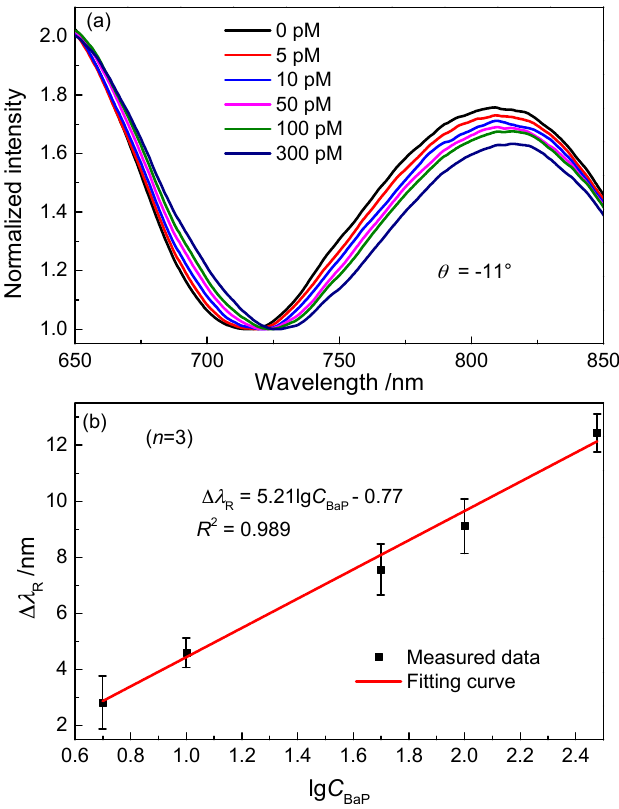
Figure 6. ( a ) SPR spectra measured at θ = − 11° with the antibody-functionalized NPG film in air after immunoreaction with BaP molecules in a series of aqueous solutions with different BaP concentrations; ( b ) the resonance-wavelength shift versus the log of BaP concentration. ( b ) the resonance-wavelength shift versus the log of BaP concentration. Table 1. Principal sensors employed in BaP